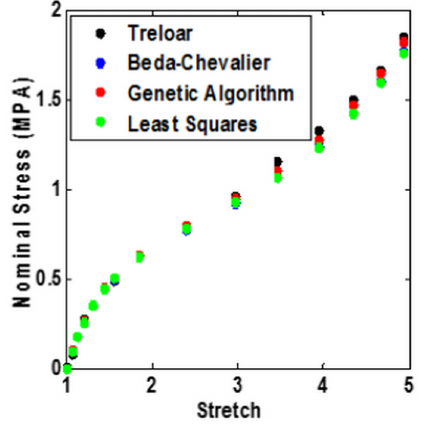
Figure 4: Pure Shear.